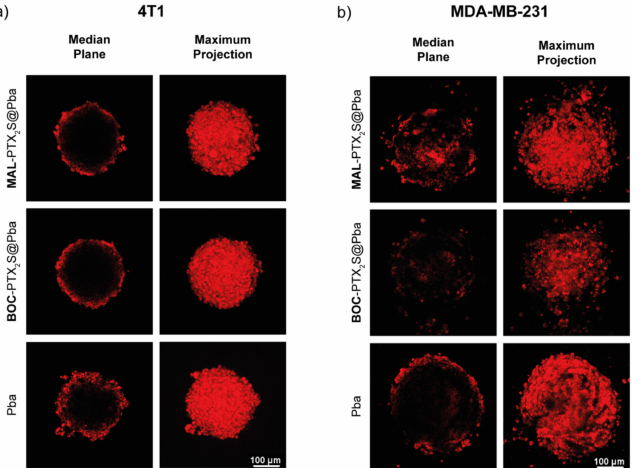
Figure 8. In vitro uptake of the different Pba formulations in 4T1 ( a ) and MDA-MB-231 ( b ) cells cultured as spheroids. Spheroids were incubated for 24 h with 0.5 µ M of Pba dissolved in the standard at the end of incubation time. Median plane images show Pba fluorescence distribution at the equatorial plane of each spheroid, whereas maximum projection images represent the fluorescence signal of the superimposition of about 50 different acquired focal planes. Scale bars: 100 µ m.